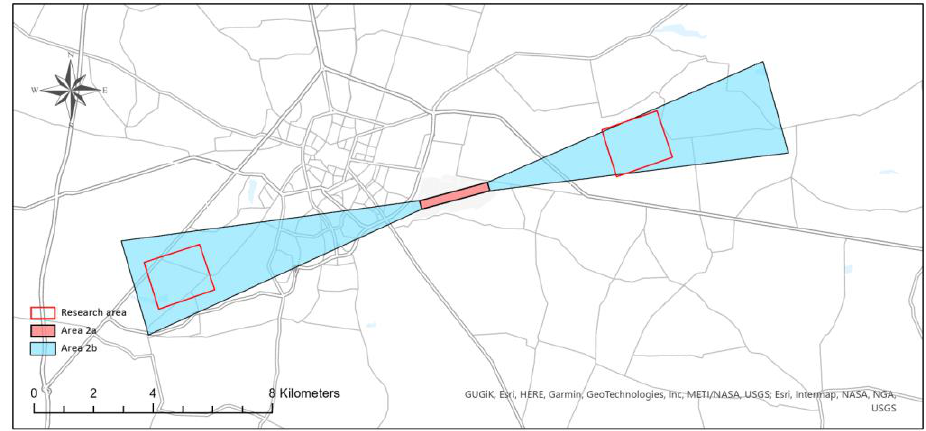
Figure 10. Test areas — Radom – Sadków airport.